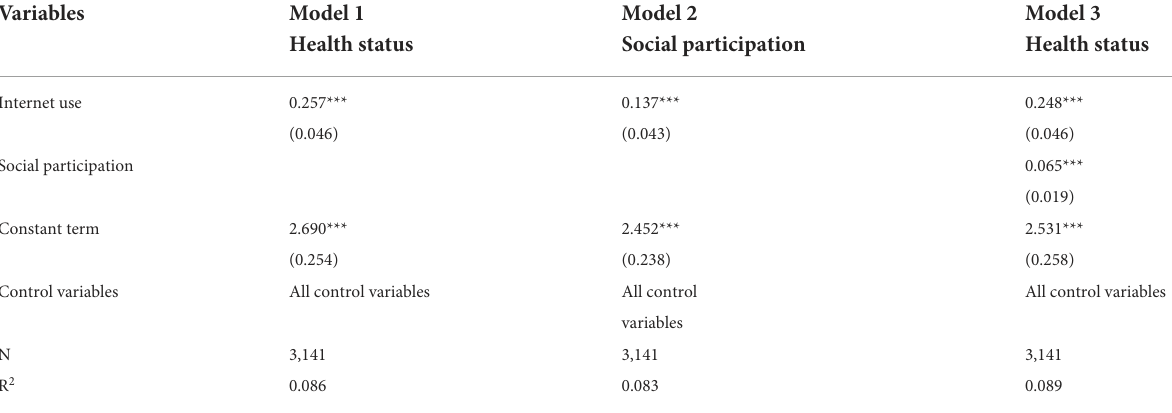
TABLE 5 Internet use and health status of older adults: Mediating role of social participation.